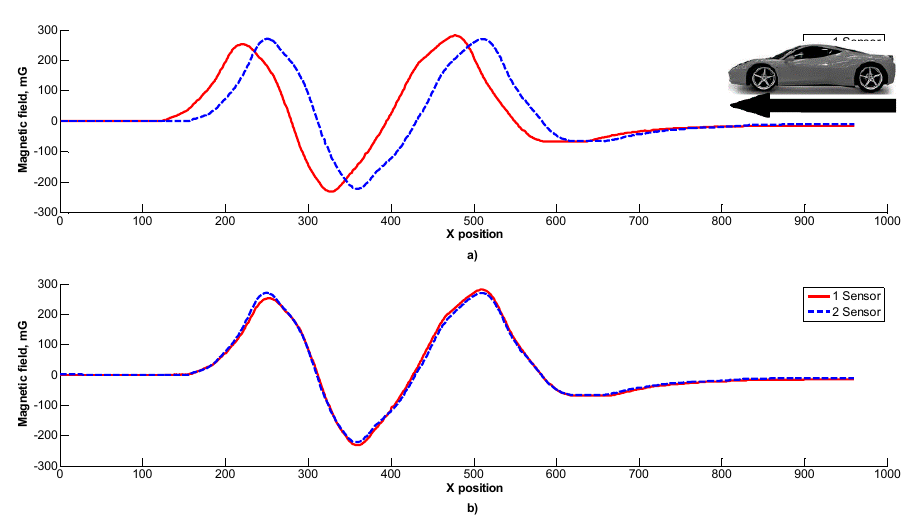
Figure 6. A view of the data samples from two sensors ( a ) and samples matching ( b ) via the use of the Z component.